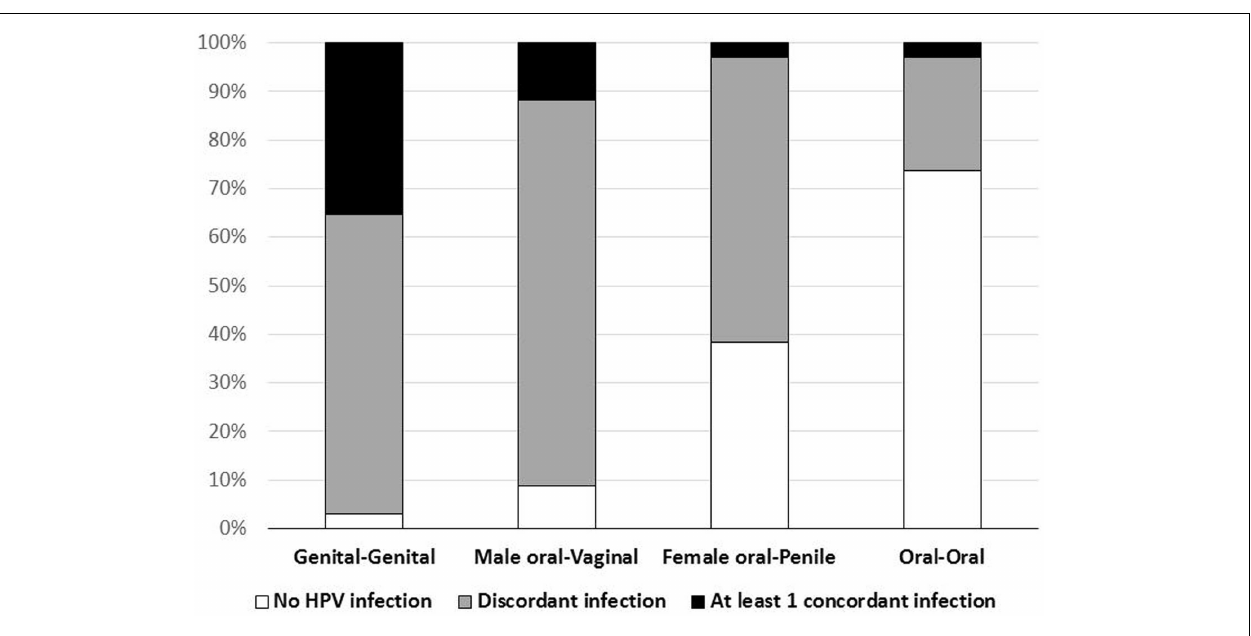
FIGURE 1 | Frequency of type-specific HPV concordance, by site, among 34 couples .